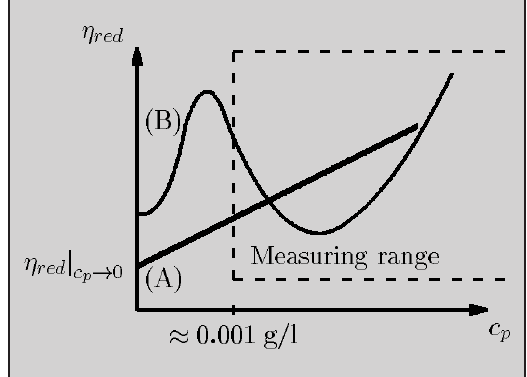
Figure 1: Schematic representation of the reduced viscosity as a function of the polymer concentration (A) neutral polymer solutions (B) iono- genic polymer